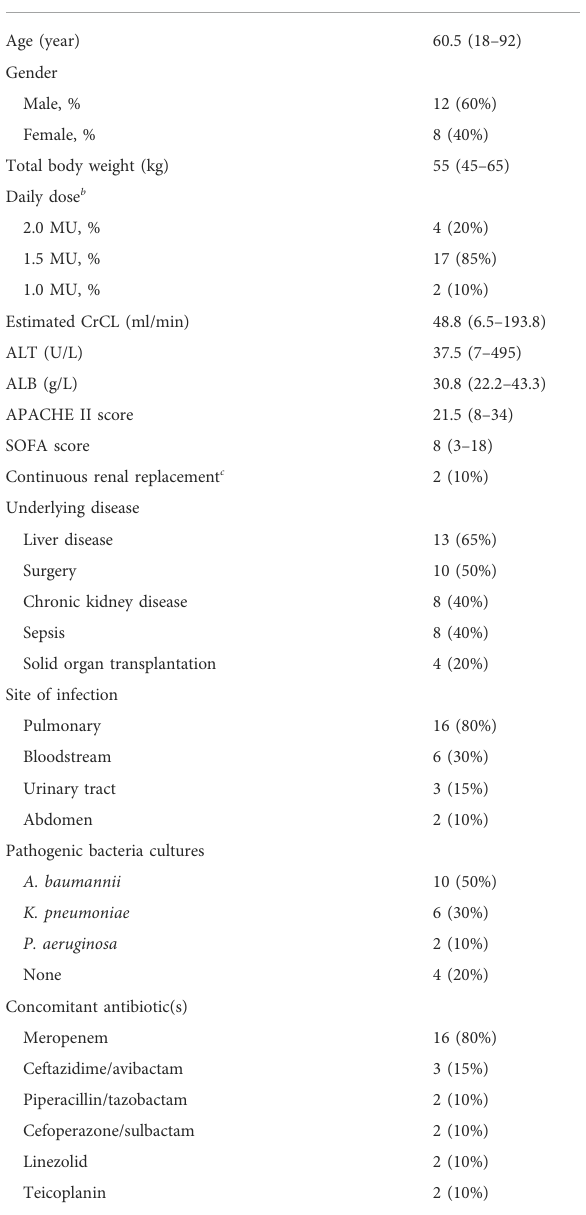
TABLE 1 Patients ’ demographic